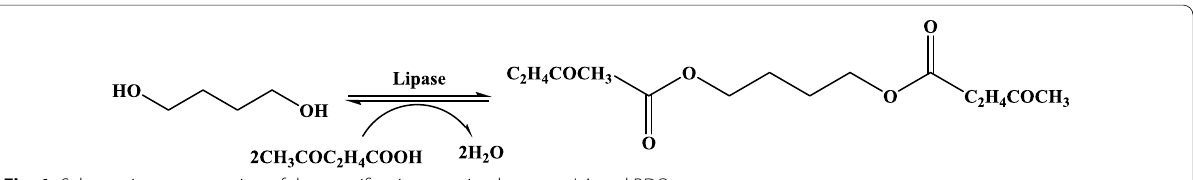
Fig. 1 Schematic representation of the esterification reaction between LA and